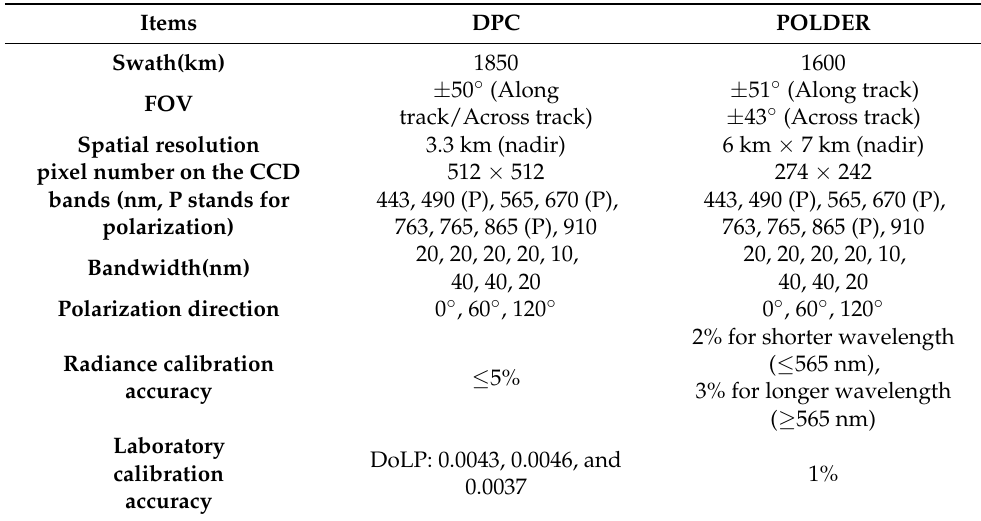
Table 1. The performance specifications of the DPC and